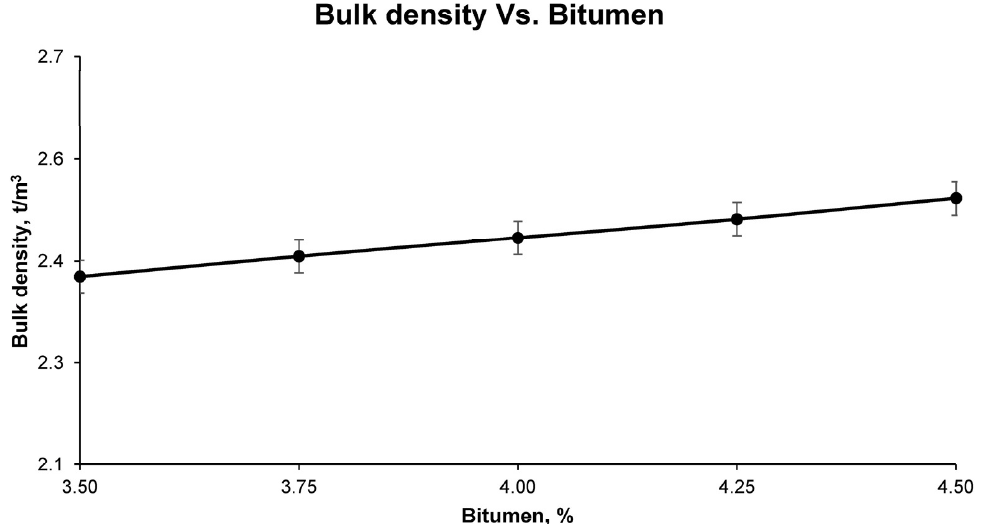
Figure 10. Bulk density of bituminous mixtures conforming with leaching residue and increasing percentages of bitumen emulsion.